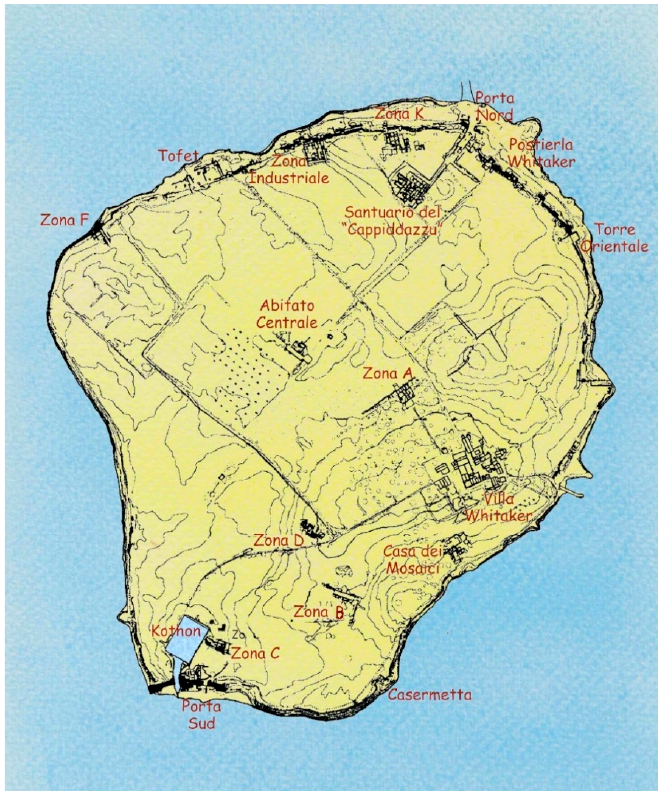
Figure 1. The site of Motya on the island of San Pantaleo in the Stagnone Lagoon, off the west coast of Sicily between Trapani and Marsala. All drawings courtesy of the Whitaker Foundation, Motya.